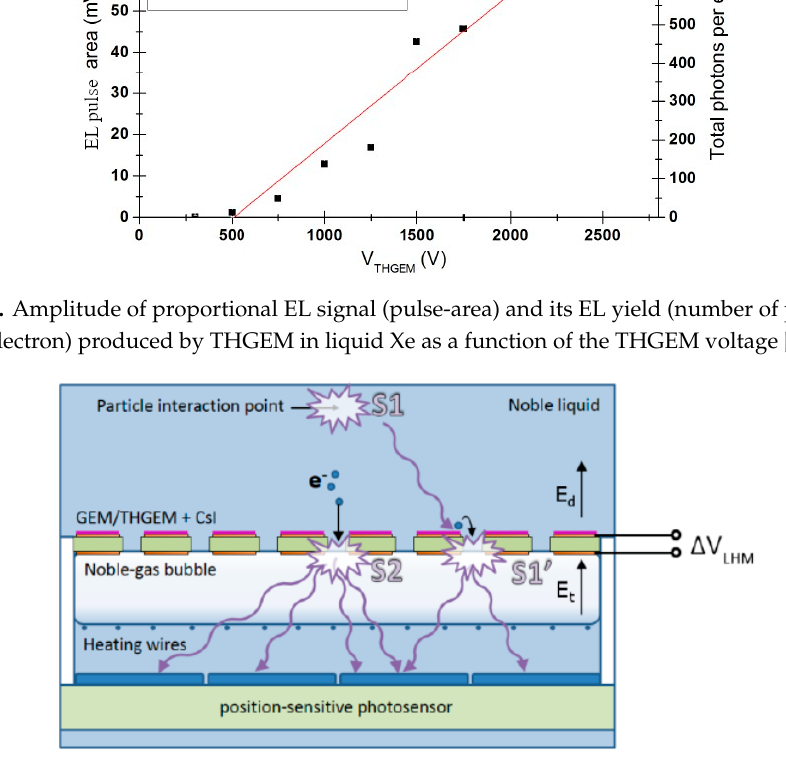
Figure 30. Concept of liquid-hole multiplier (LHM) detector [57–59].